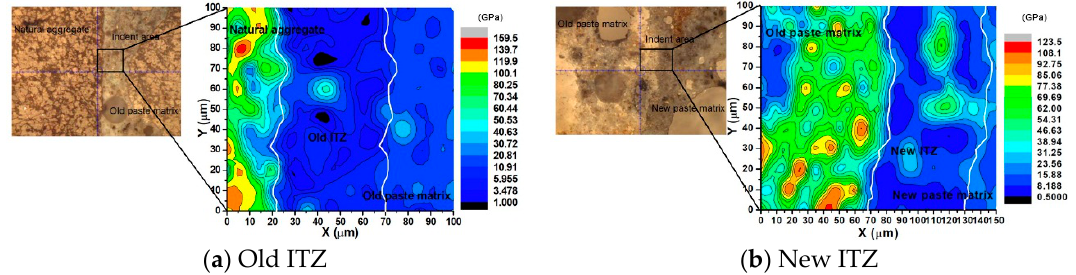
Figure 2. Nanomechanical properties of interfacial transition zones (ITZs). ( a ) Old ITZ ( b ) New ITZ